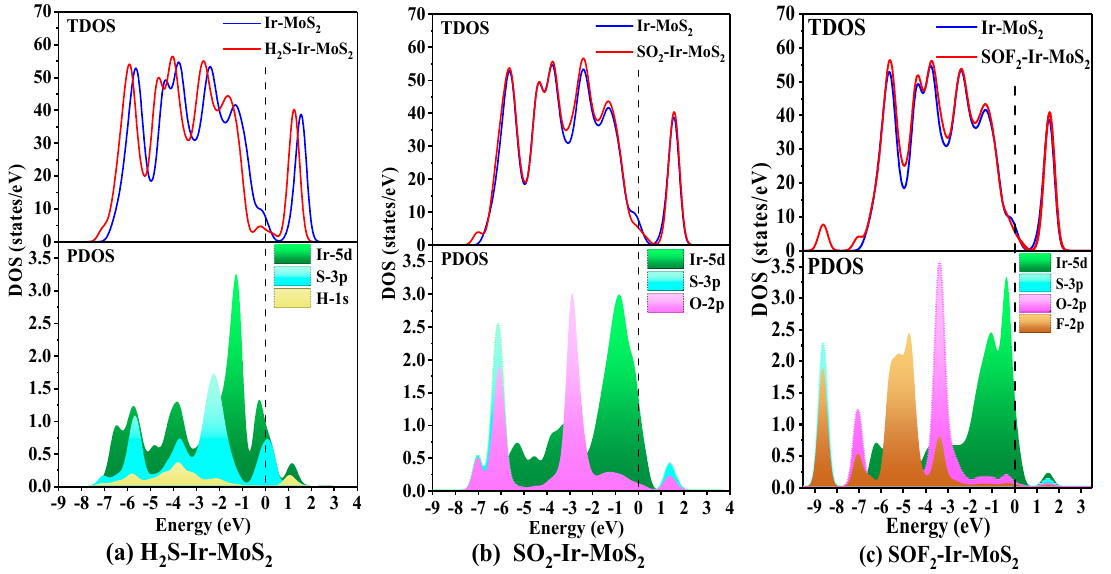
Figure 8. The DOS distributions of different adsorption systems.